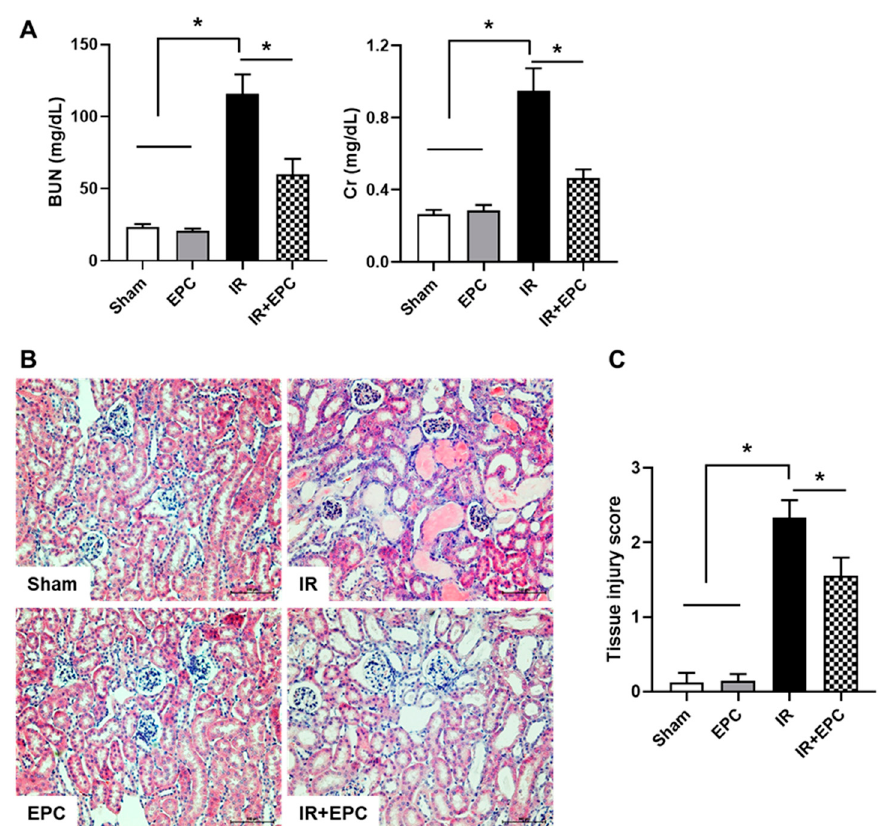
Figure 2. Effects of EPCs on renal function and morphological changes during IRI. EPCs (5 × 10 5 cells) were administered through the tail vein. Mice were sacrificed 72 h after ischemic injury for blood and kidney sampling. The blood urea nitrogen (BUN) and serum creatinine (Cr) levels were measured ( A ). Histological changes were examined by hematoxylin and eosin staining ( B ), and tissue damage was quantified ( C ). Scale bar, 100 μ m. Data are means ± SEMs. * p < 0.05.